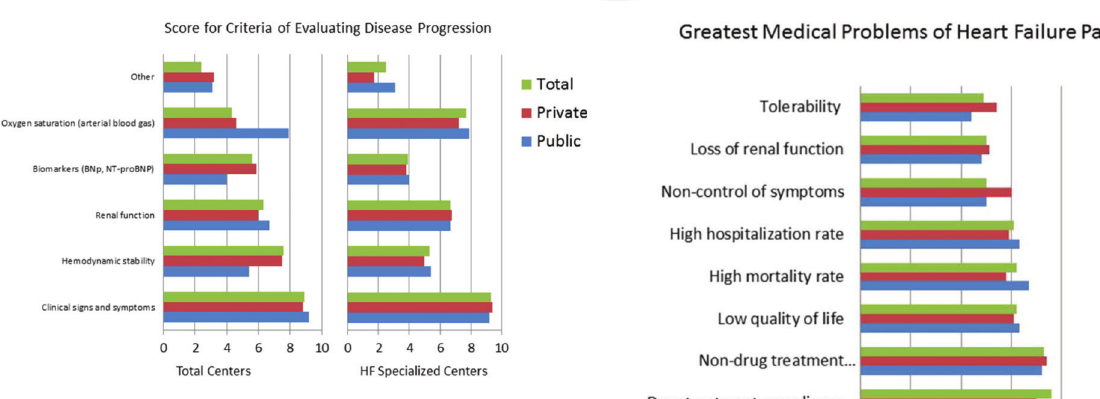
Figure 1 - Perceptions of doctors in centers treating heart failure (HF) regarding a criteria for evaluation of HF disease progression using a score in total, private, and public HF patients in HF specialized and all centers.